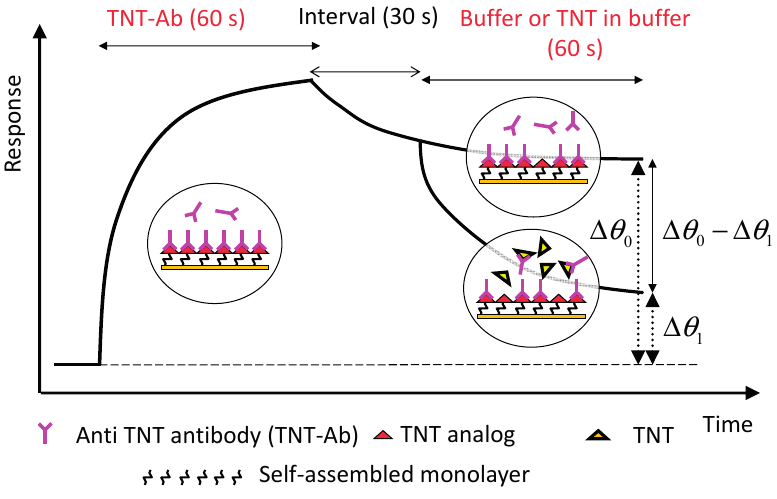
Figure 9. Principle of displacement assay on an SPR